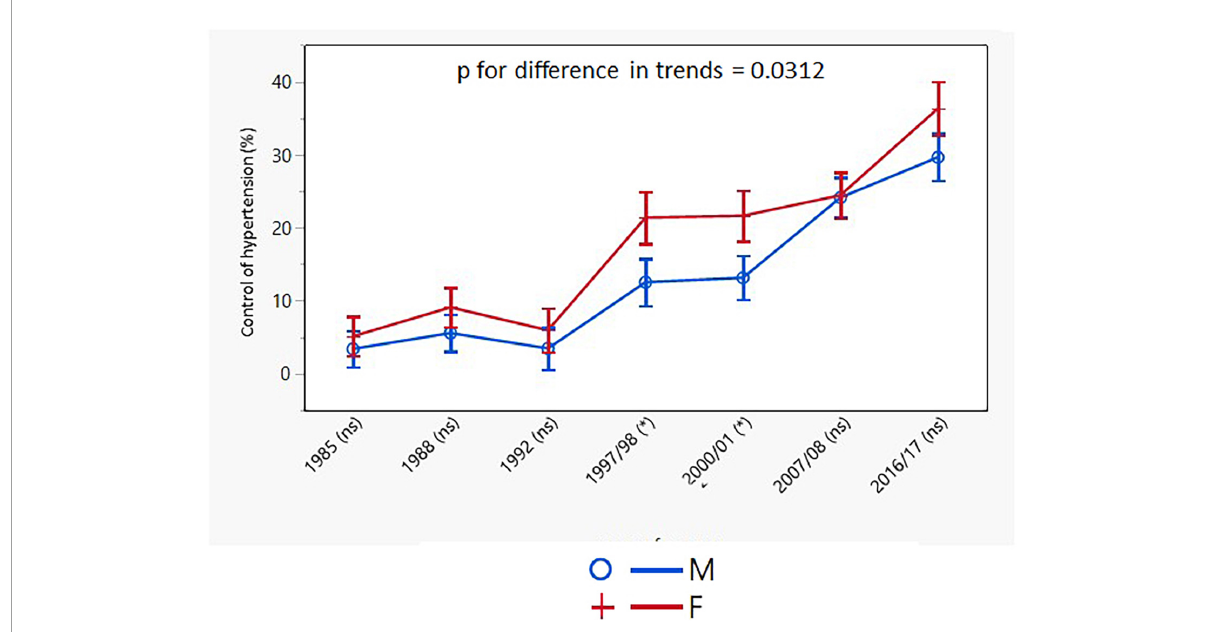
FIGURE7 Age-adjusted trends in control of hypertension in all hypertensive individuals (95% confidence interval). M, males; F, females; p for differences in trends between males and females. NS or asterisks indicates in brackets after survey years the sex differences in respective surveys after Bonferroni correction; * p < 0.05.